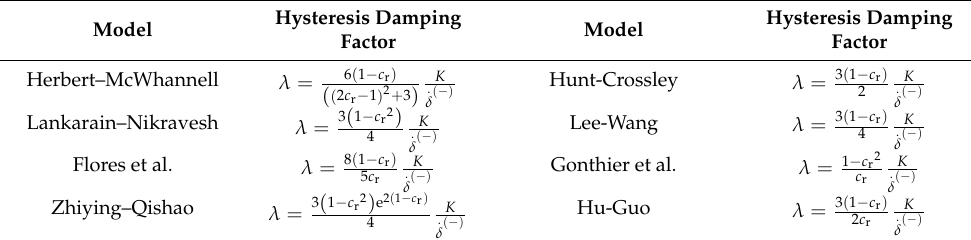
Table 1. Classical expressions of hysteresis damping factor.